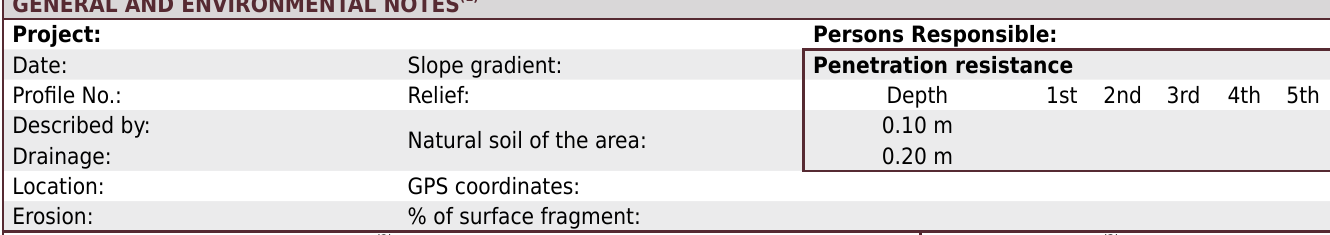
Table 1. Protocol for describing urban soils GENERAL AND ENVIRONMENTAL NOTES